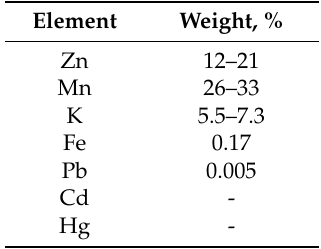
Table 1. Alkaline batteries paste analysis